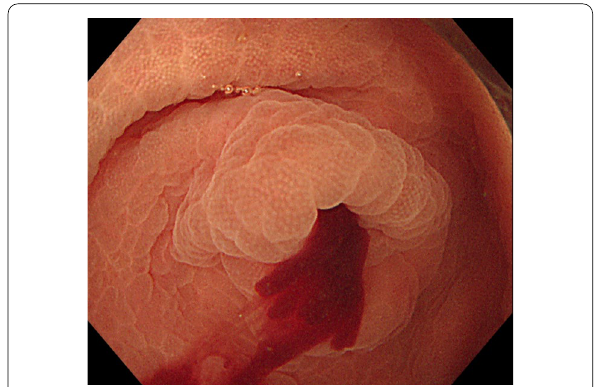
Fig. 1 Lower gastrointestinal endoscopic findings. Bleeding is observed from the appendiceal orifice